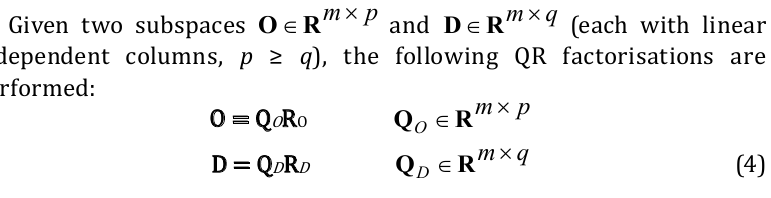
Figure 1. Angle ϕ formed by active subspaces representing the reference and current states